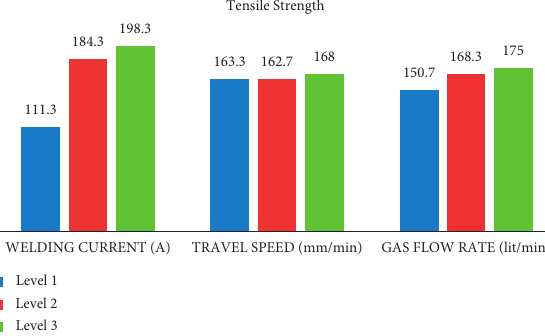
Figure 5: Effect of welding parameters over tensile